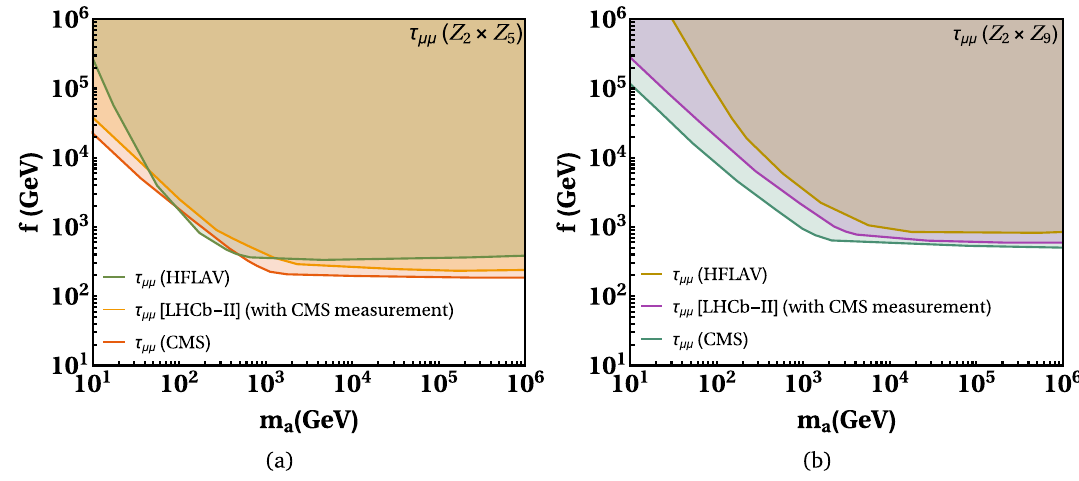
Fig. 7 The allowed parameter space by τ μμ for λ χ = 2 in the m a − f plane for the recent measurement and the future projected sensitivity of the LHCb for the minimal ( Z 2 × Z 5 ) model on the left, and for the non-minimal ( Z 2 × Z 9 ) model on the